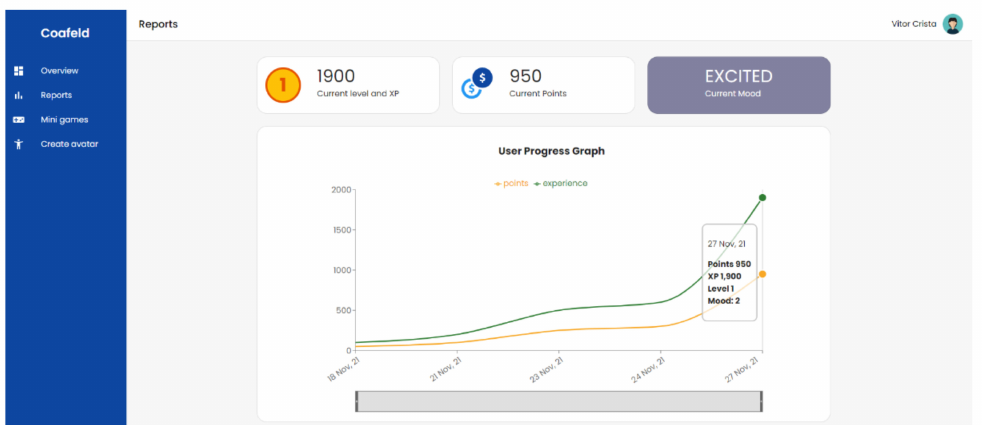
Figure 2. User progress interface. The user can access his/her current game experience in terms of points and experience acquired and the corresponding level. All points earnt can be used to unlock additional content inside the